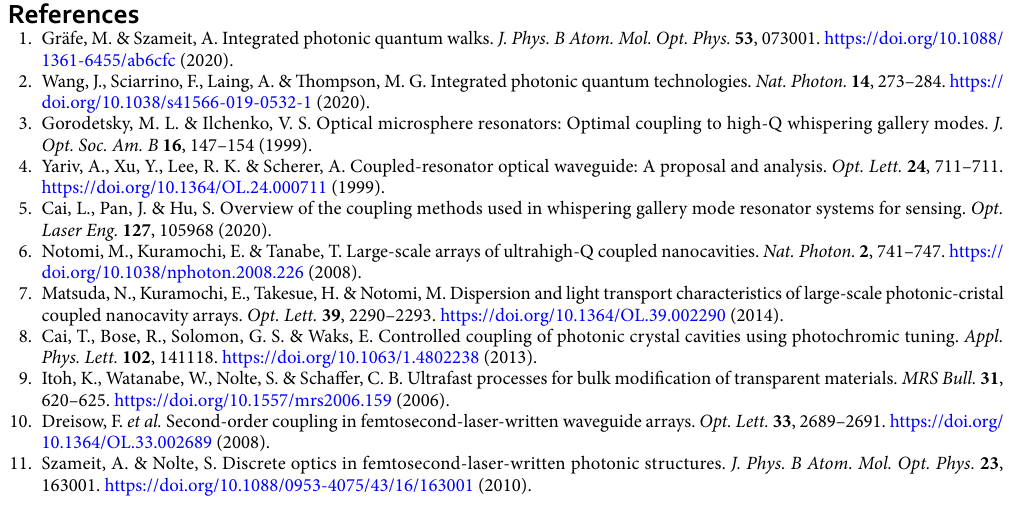
Figure 1. Fidelity in a so-called J x resonator network with five elements, j 1 , and ( b ) squeezed vacuum state with squeezing amplitude r coherent state, α = network of this size, perfect quantum state transfer from the first to the last resonator occurs at gt perfect quantum state reconstruction at the initial resonator occurs at gt = π as witnessed by a unit value of the